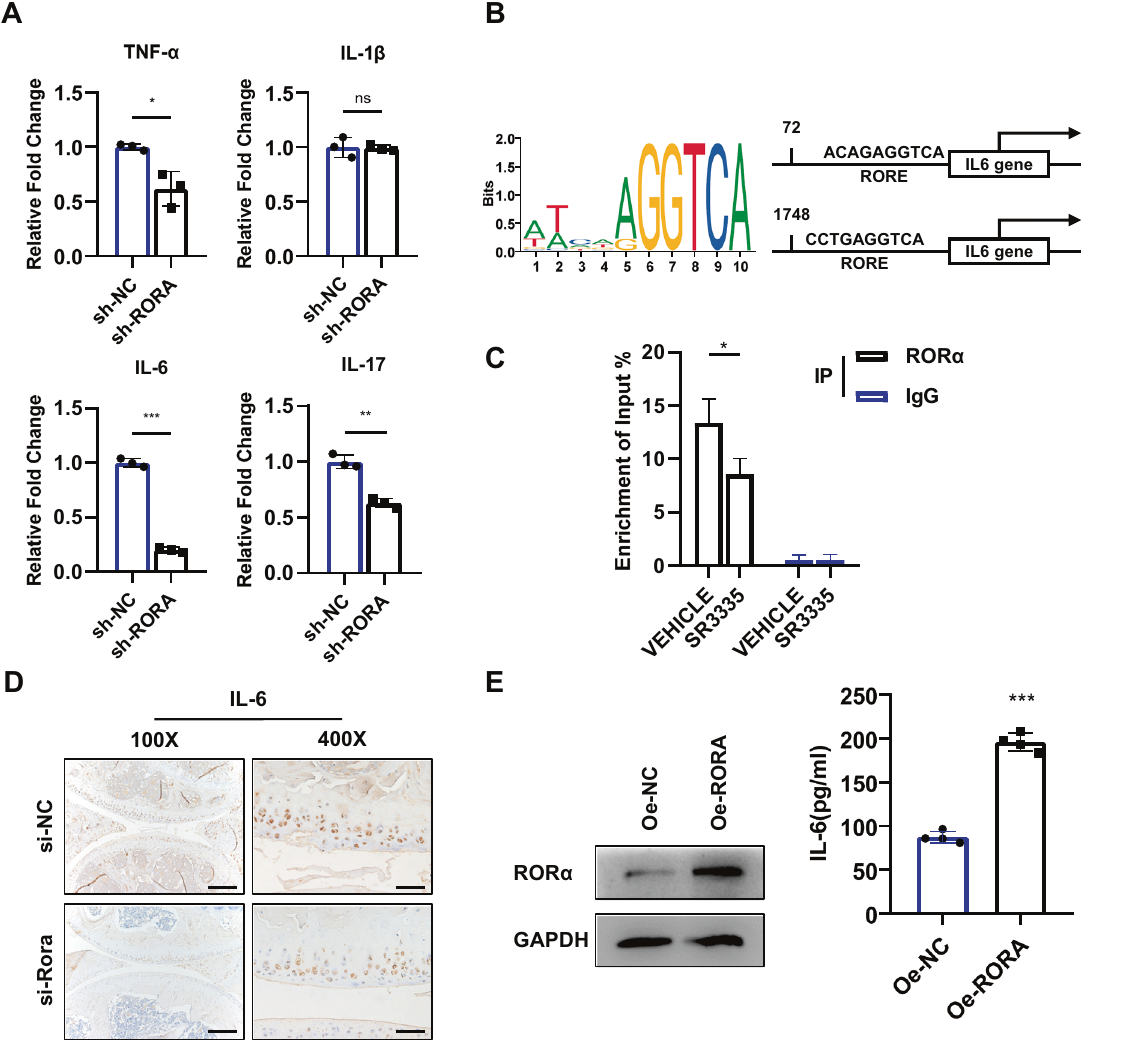
Fig. 7 ROR α regulates IL-6 expression by interacting with IL-6 promoters. A Real-time PCR analysis of TNF- α , IL-1 β , IL-6, and IL-17 mRNA in human chondrocytes infected with RORA knockdown lentivirus (sh-RORA) or control lentivirus (sh-NC) ( n = 3). B Schematic diagram of the potential binding site for ROR α in the promoter region of IL-6 using JASPAR database. C ChIP-qPCR enrichment assay was performed on chondrocytes with anti-ROR α antibody or IgG. The chondrocytes were pretreated with vehicle or 1 μ M SR3335 for 6 h. IgG immunoprecipitation was used as a negative control. D IHC staining for IL-6 of articular cartilage after indicated adenovirus injection for 6 weeks in mice. Scale bars, 200 μ m for ×100 picture and 50 μ m for ×400 picture. E ELISA assay to detect IL-6 protein expression after transfected with RORA overexpression or vector plasmid for 48 h ( n = 4). The statistical data in A , C , and E were analyzed with Student ’ s t test. * P < 0.05, ** P < 0.01, *** P < 0.001, ns = no signi fi cance. All data shown above are presented as mean ± in the fi gure represent the average Δ Ct value of all experiments. The and Hochberg ’ s approach for controlling the false discovery rate. The primer sequences used in this study are listed in Supplementary Table 1. adjusted P value <0.05 for certain genes was regarded as differentially expressed. The GSE accession number for the RNA-seq data is GSE172291. Enzyme-linked immunosorbent assay (ELISA) The IL-6 level in culture supernatants was measured using ELISA kits (Neobioscience, Shenzhen, China) according to the manufacturer ’ s instructions. RNA-seq analysis To generate mRNA-sequencing data, two groups of chondrocytes with different treatments, vehicle, and SR3335 treated, were analyzed by RNA- sequencing. The RNA was extracted with TRIzol and an amount of 1 µg RNA was used as input material for the RNA sample preparations. Sequencing libraries were generated according to the manufacturer ’ s recommendations. Differential expression analysis of control and SR3335- treated groups (three biological replicates) was performed using the DESeq2 R package. The resulting P values were adjusted using Benjamini